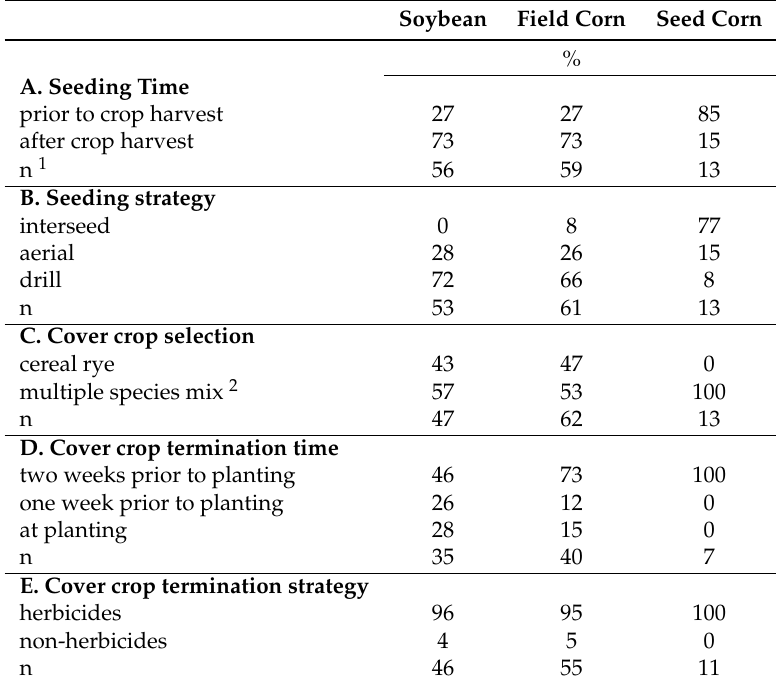
Table 1. Cover crop management strategies in Nebraska according to survey respondents.